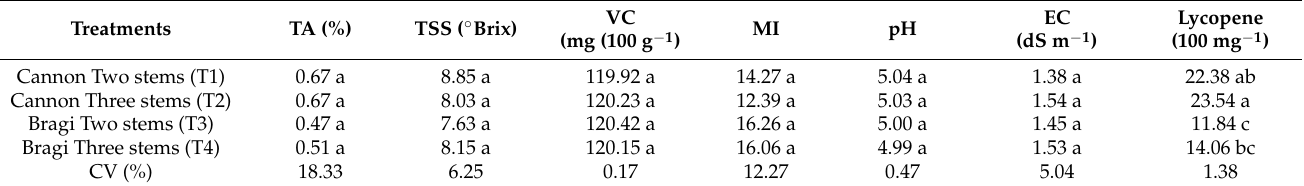
Table 1. Content of titratable acidity (TA), total soluble solids (TSS), vitamin C (VC), maturity index (MI), pH, electrical conductivity (EC) and lycopene for bell pepper ‘Cannon’ and ‘Bragi’. Treatments TA (%) Cannon Two stems